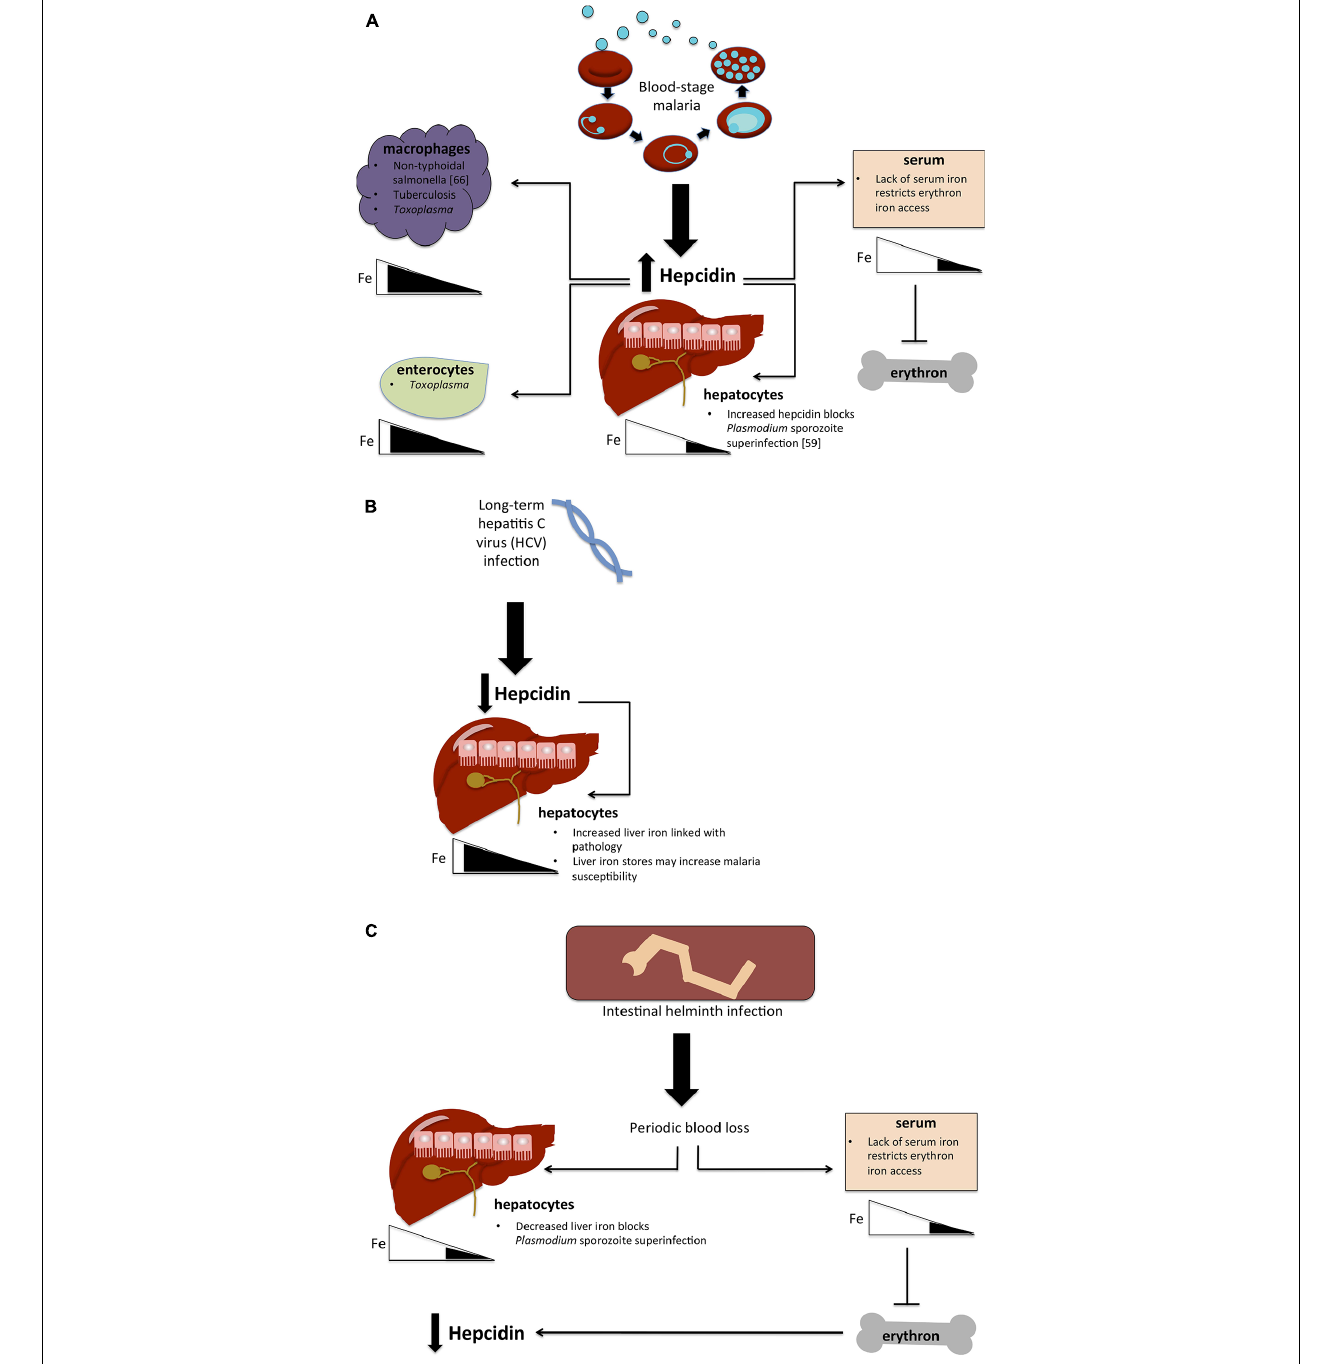
exploit the macrophage niche (non-typhoidal salmonella, tuberculosis, Toxoplasma ) and those that require iron in enterocytes ( Toxoplasma ). (B) Hypothesized effect of HCV infection on malaria susceptibility. Long-term HCV infection causes hepcidin suppression, thus increasing liver iron stores and plausibly increasing malaria susceptibility. (C) Potential impact of intestinal helminth infection. Helminths cause periodic blood loss, which restricts iron to the liver, potentially blocking malaria liver-stage infection as in (A) . Decreases in serum restrict iron availability for erythropoiesis, causing anemia, which in turn causes the downregulation of